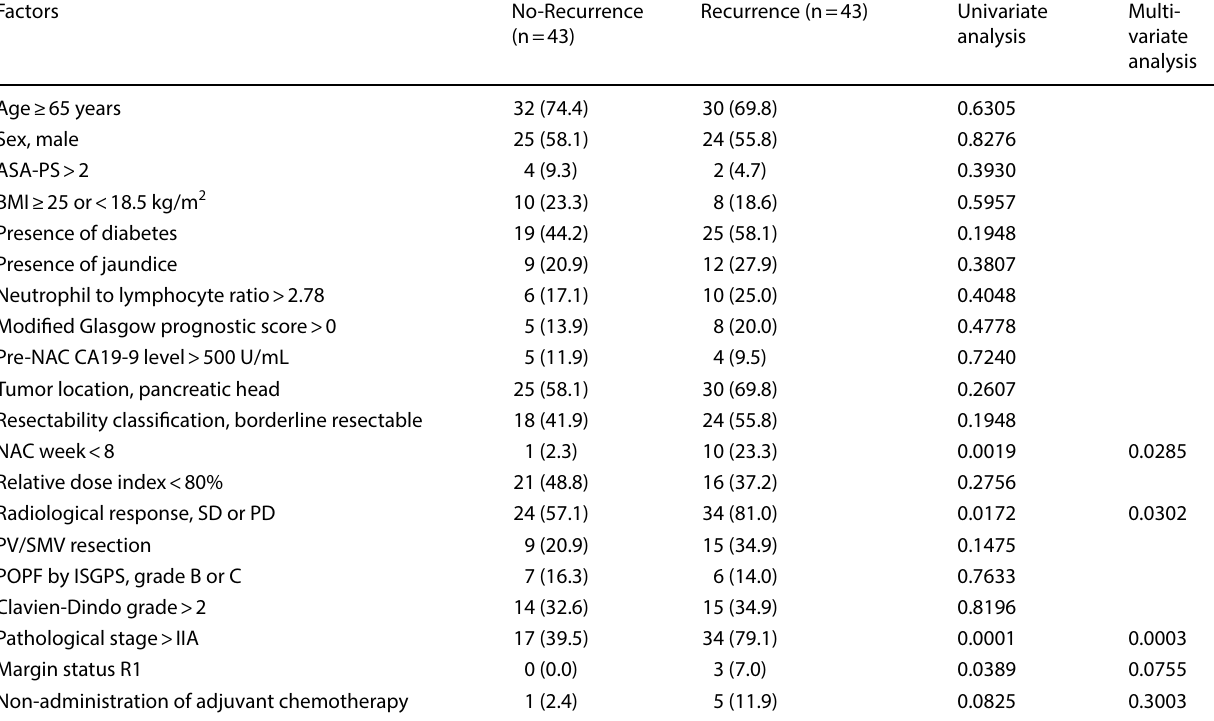
Table 4 Univariate and multivariate analyses of predictive factors associated with postoperative recurrences in the